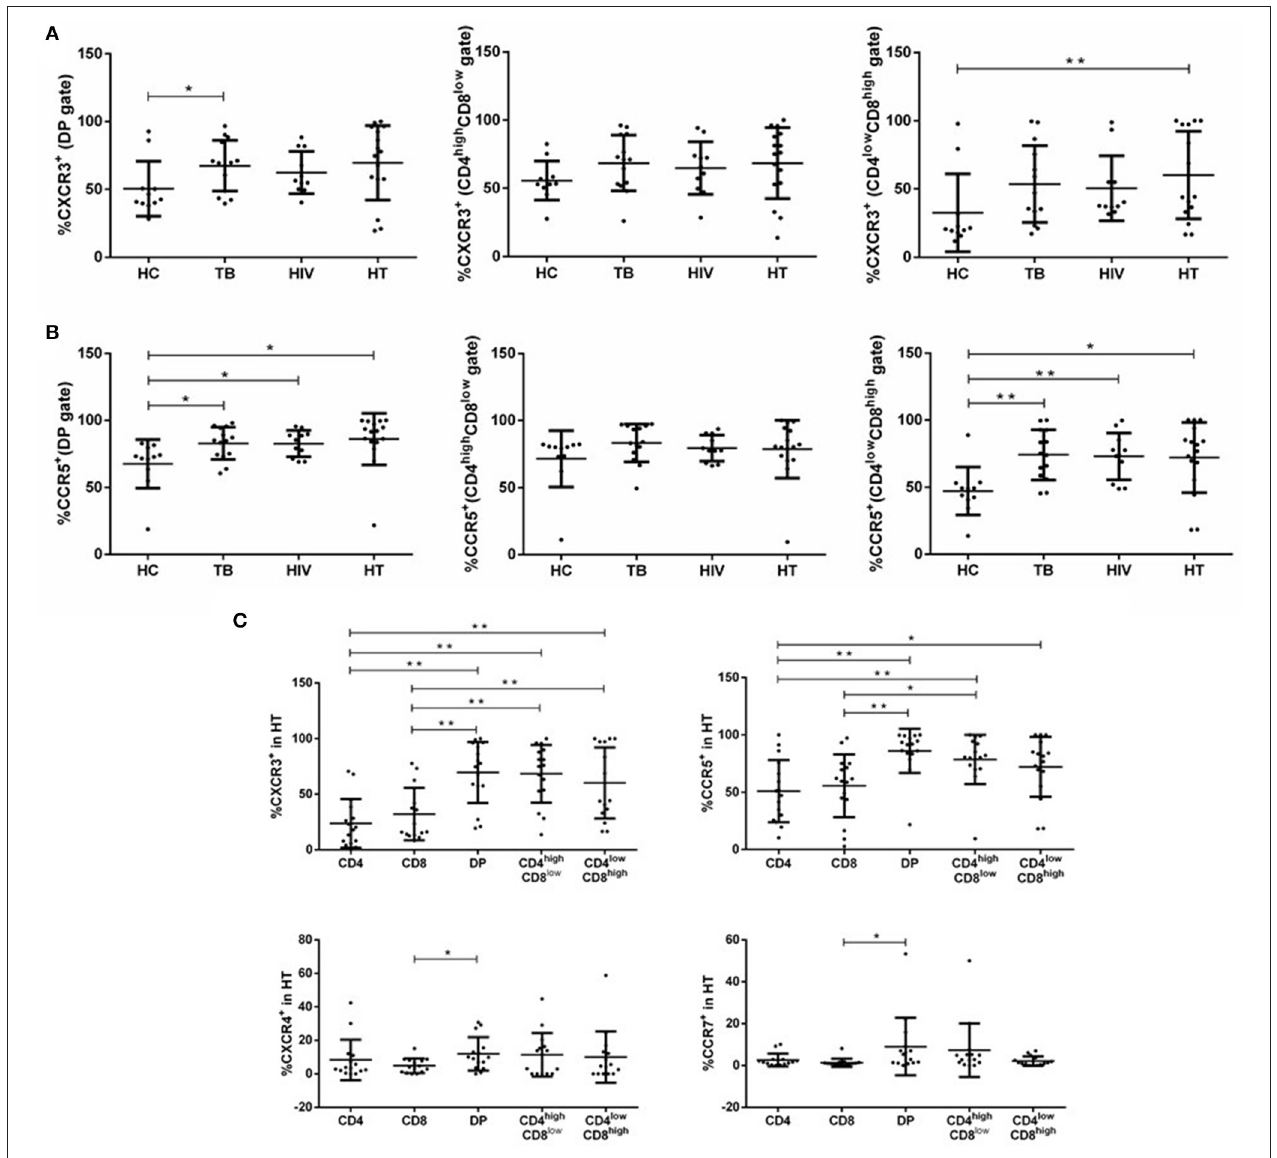
FIGURE 3 | Distribution of chemokine receptors among subsets of DP T cells in each group. Percentages of DP T subsets expressing CXCR3 (A) and CCR5 (B) within each group are shown. Subjects for chemokine receptor expression of CXCR3, CCR5, CXCR4, and CCR7 in T-lymphocyte subsets in the HT group are shown in (C) . P -value calculated using the Mann–Whitney U test. Statistically significant differences between the groups are indicated as follows: * p < 0.05 and ** p <